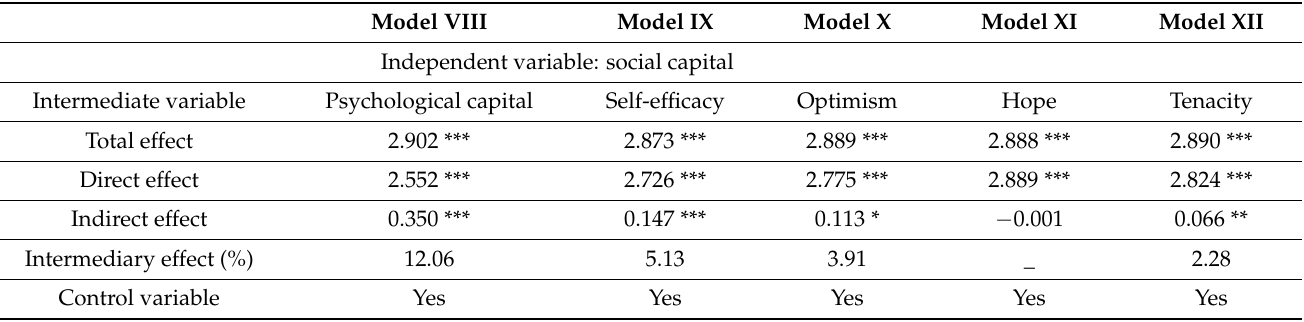
Table 8. KHB test results of the mediating effect of psychological capital on each